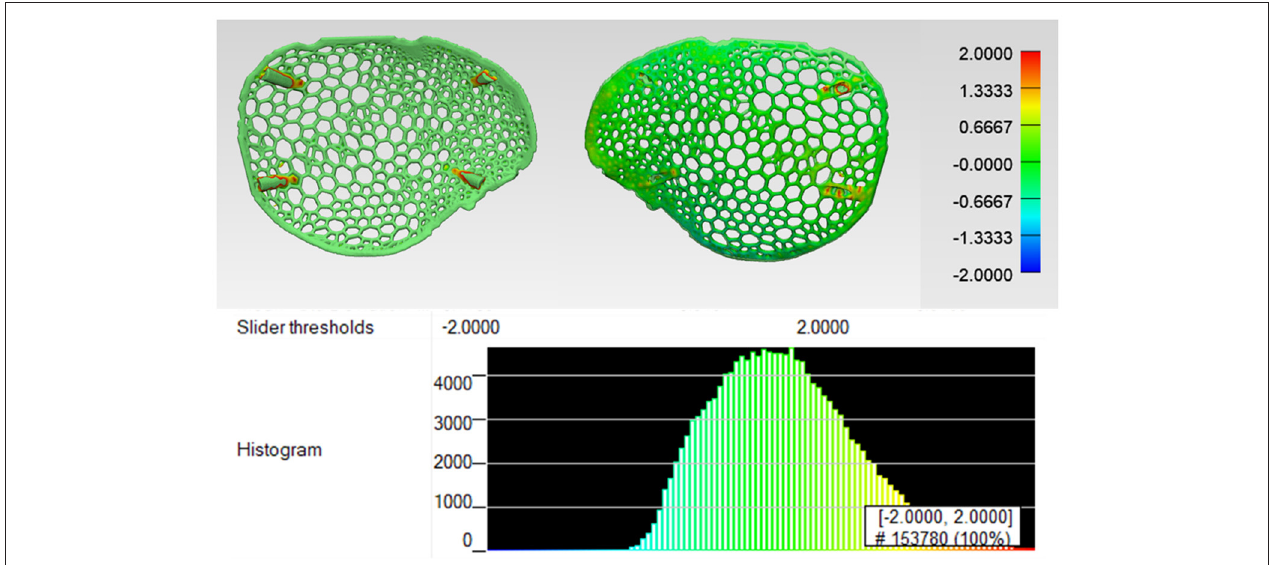
FIGURE 9 | Dimensional accuracy assessment of biomimetic, organic Voronoi pattern